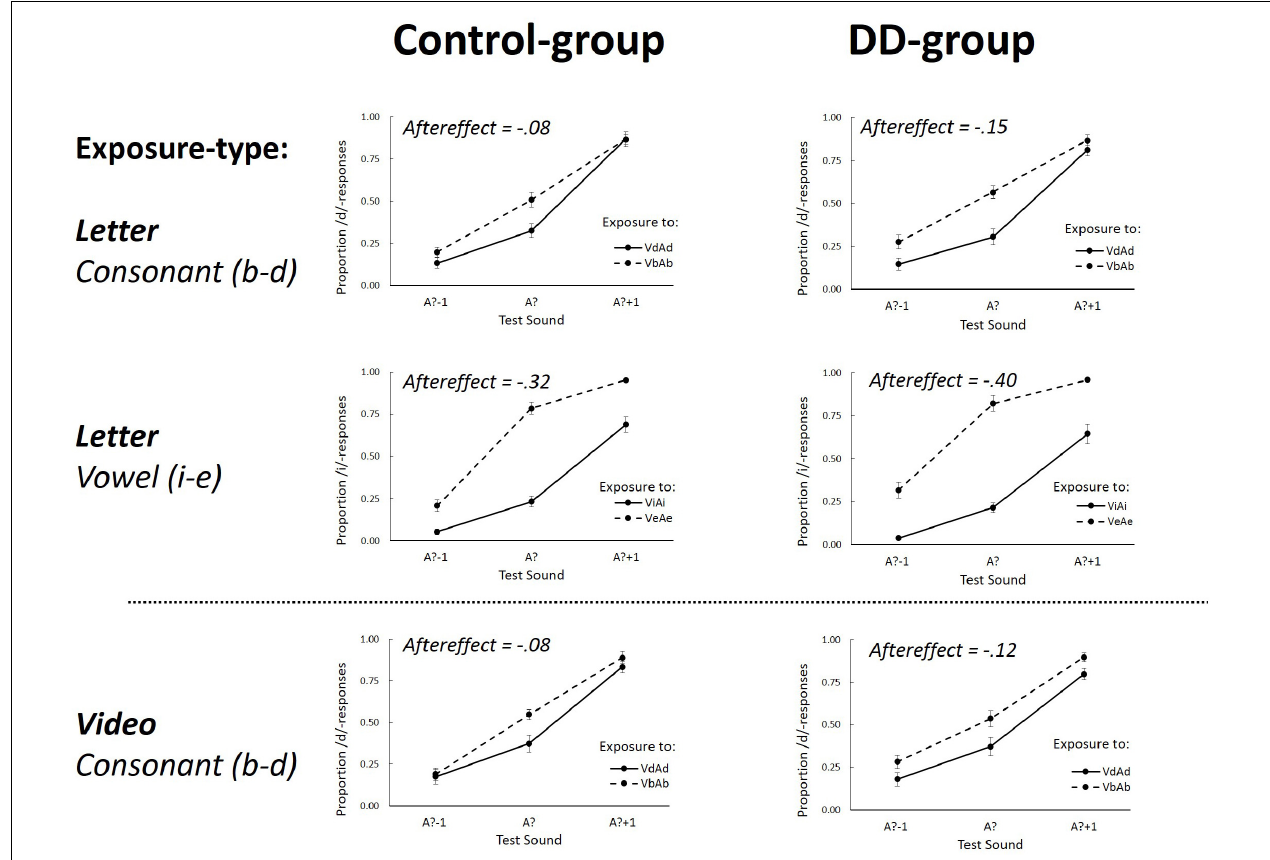
FIGURE 3 | The proportion /d/ (Experiment 1, Consonant) or /i/-responses (Experiment 2, Vowel) as a function of the three different Test-sounds (A?–1; A? and A?+1) after non-ambiguous Exposure-sounds. Graphs separately depict Letter (upper four graphs) and Video (lower two graphs) Exposure-types for the Control group (left graphs) and DD group (right graphs). Aftereffects represents the overall difference between the two Exposure-tokens (VdAd – VbAb for the consonants, and ViAi–VeAe for the vowels). Error bars represent the standard errors of the